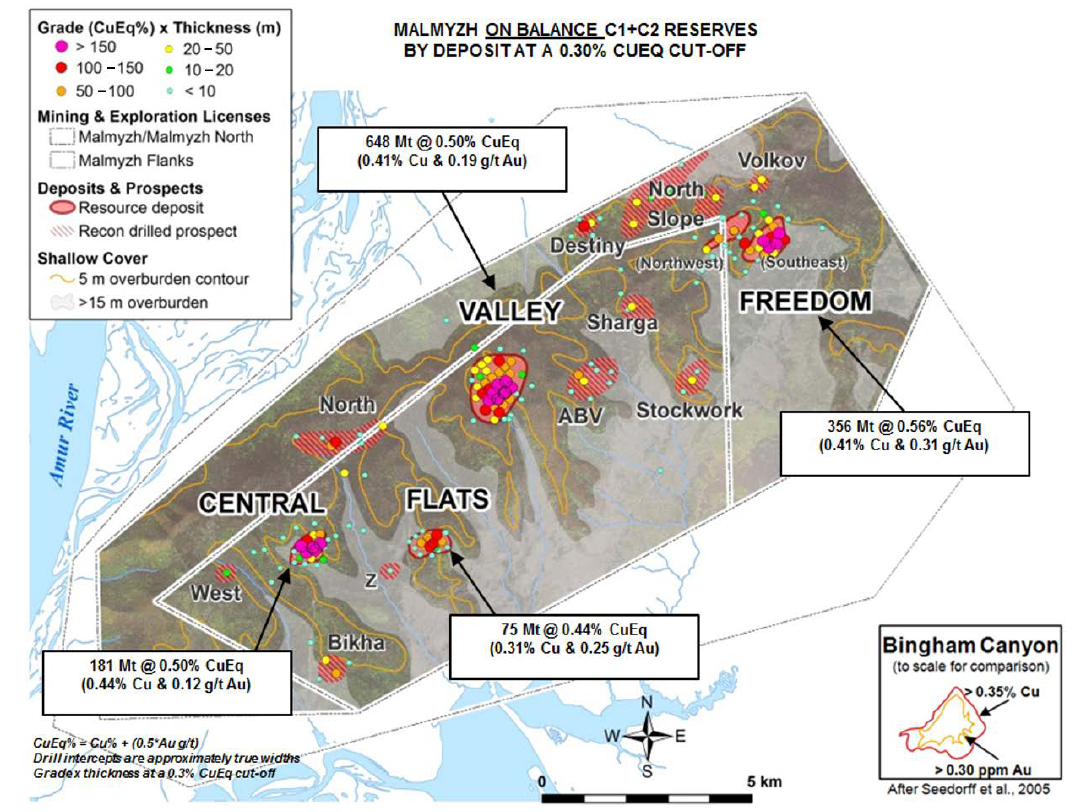
Figure 1. Geology, Reserve and Resource